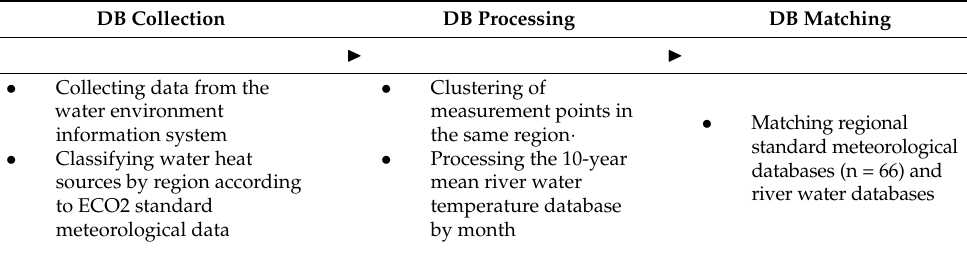
Table 1. Database (DB) collection process for data on river water heat